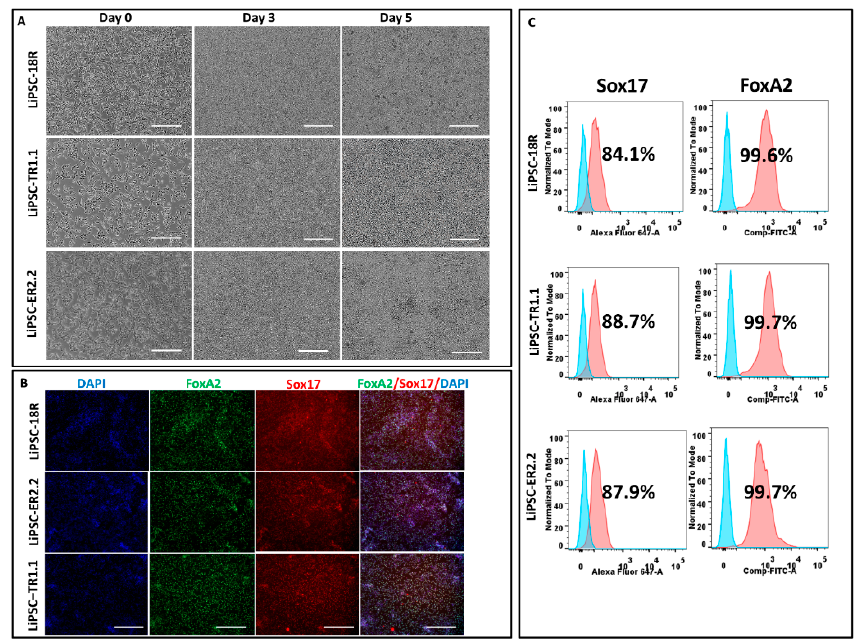
Figure 3. Differentiation of human iPSCs into definitive endoderm (DE) one passage post thaw. ( A ) Morphology of LiPSCs-derived cells was changing during the differentiation from day 1 to day 5. The cells were highly proliferative during the differentiated period and produced dense single-layered sheets. ( B ) Immunofluorescent staining of day 5 cells (all three LiPSC lines) revealed that they express DE-specific markers (FoxA2 and Sox17). ( C ) Flow cytometry analysis at the end of day 5 demonstrated that more than 80% of LiPSC 18R-derived cells express Sox17 and more than 99.0% express FoxA2. Scale bars, 100 µm.